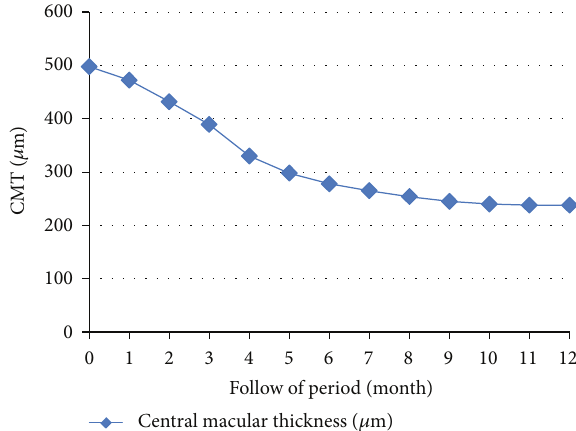
Figure 3: Changes in central macular thickness before and after surgery on a monthly